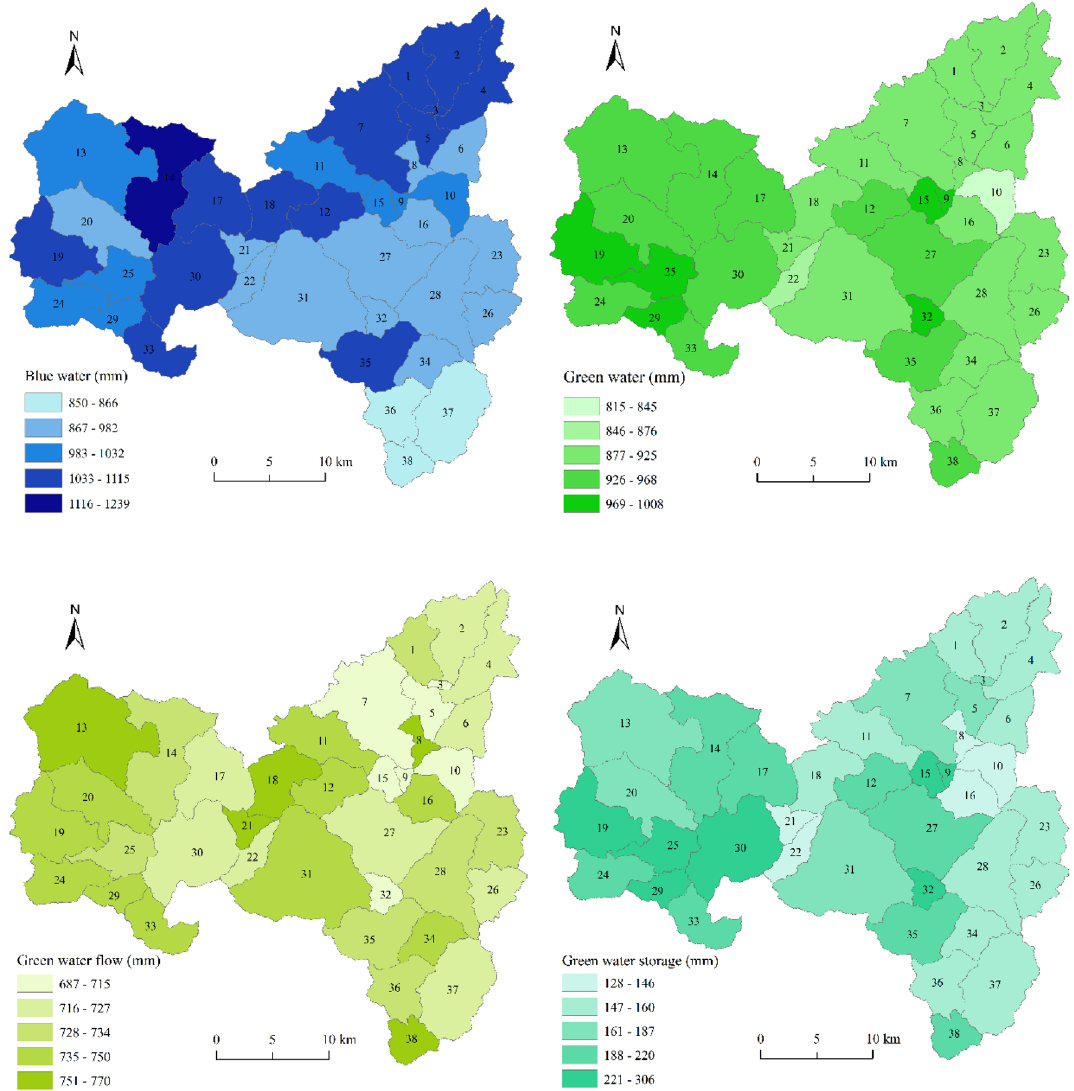
Figure 5. Spatial distribution for BW, GW, GWF, and GWS in the